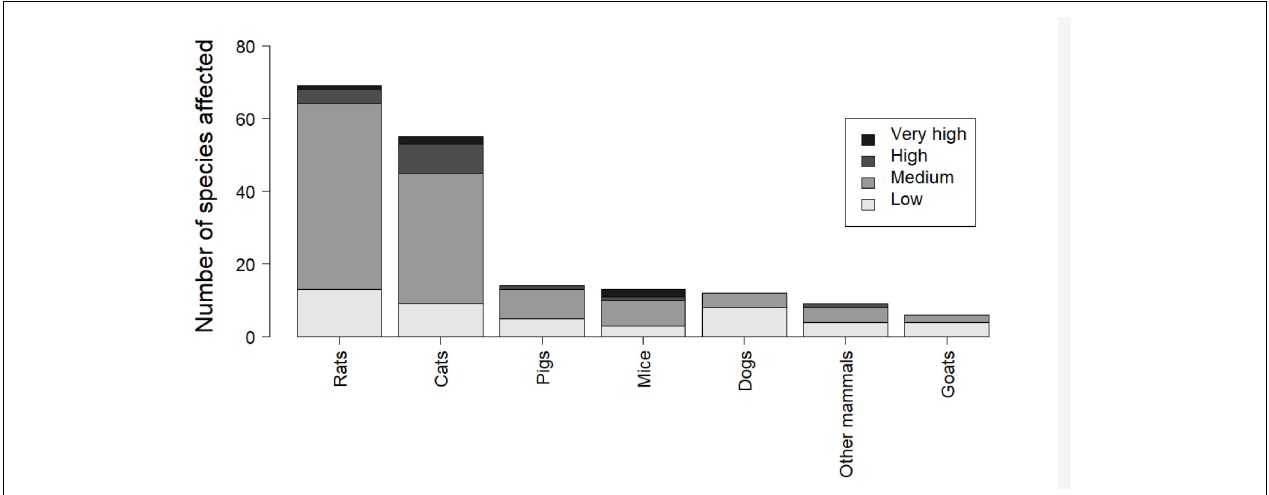
FIGURE 3 | Number of petrel species (Procellariidae, Oceanitidae, and Hydrobatidae families) affected by introduced mammalian species according to BirdLife International